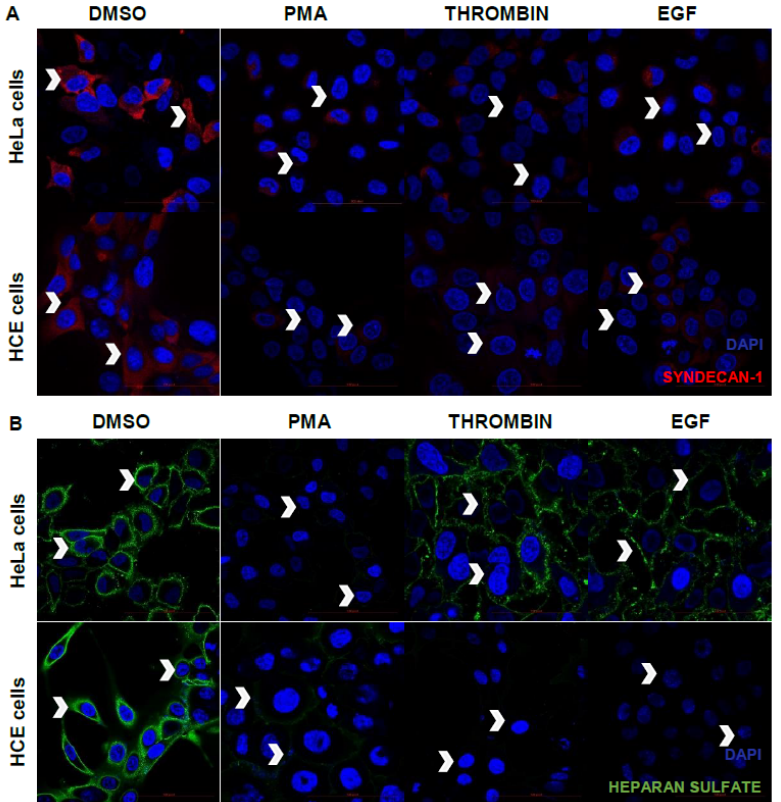
Figure 5. PMA, thrombin, and EGF treatment reduces syndecan-1 and heparan sulfate cell surface expression from HeLa and HCE cells. ( A ) Immunofluorescence microscopic images of the cell surface expression of syndecan-1 on HeLa cells and HCE cells after treatment with PMA (1 µ M), thrombin (10 ng/mL), and EGF (5 mg/mL) in serum-free media. Nuclei are stained blue with DAPI, and syndecan-1 is stained red with anti-Alexa fluor 647 antibody. Arrows indicate the syndecan-1 shedding from the cell surface relative to the DMSO (control)-treated cells at × 63 magnification. ( B ) Immunofluorescence microscopic images of syndecan-1 on HeLa cells and HCE cells after treatment with PMA (1 µ M), thrombin (10 ng/mL), and EGF (5 mg/mL) in serum-free media. Nuclei are stained blue with DAPI, and heparan sulfate is stained green with FITC-conjugated antibody. Arrows indicate the clipped heparan sulfate from the cell surface at × 63